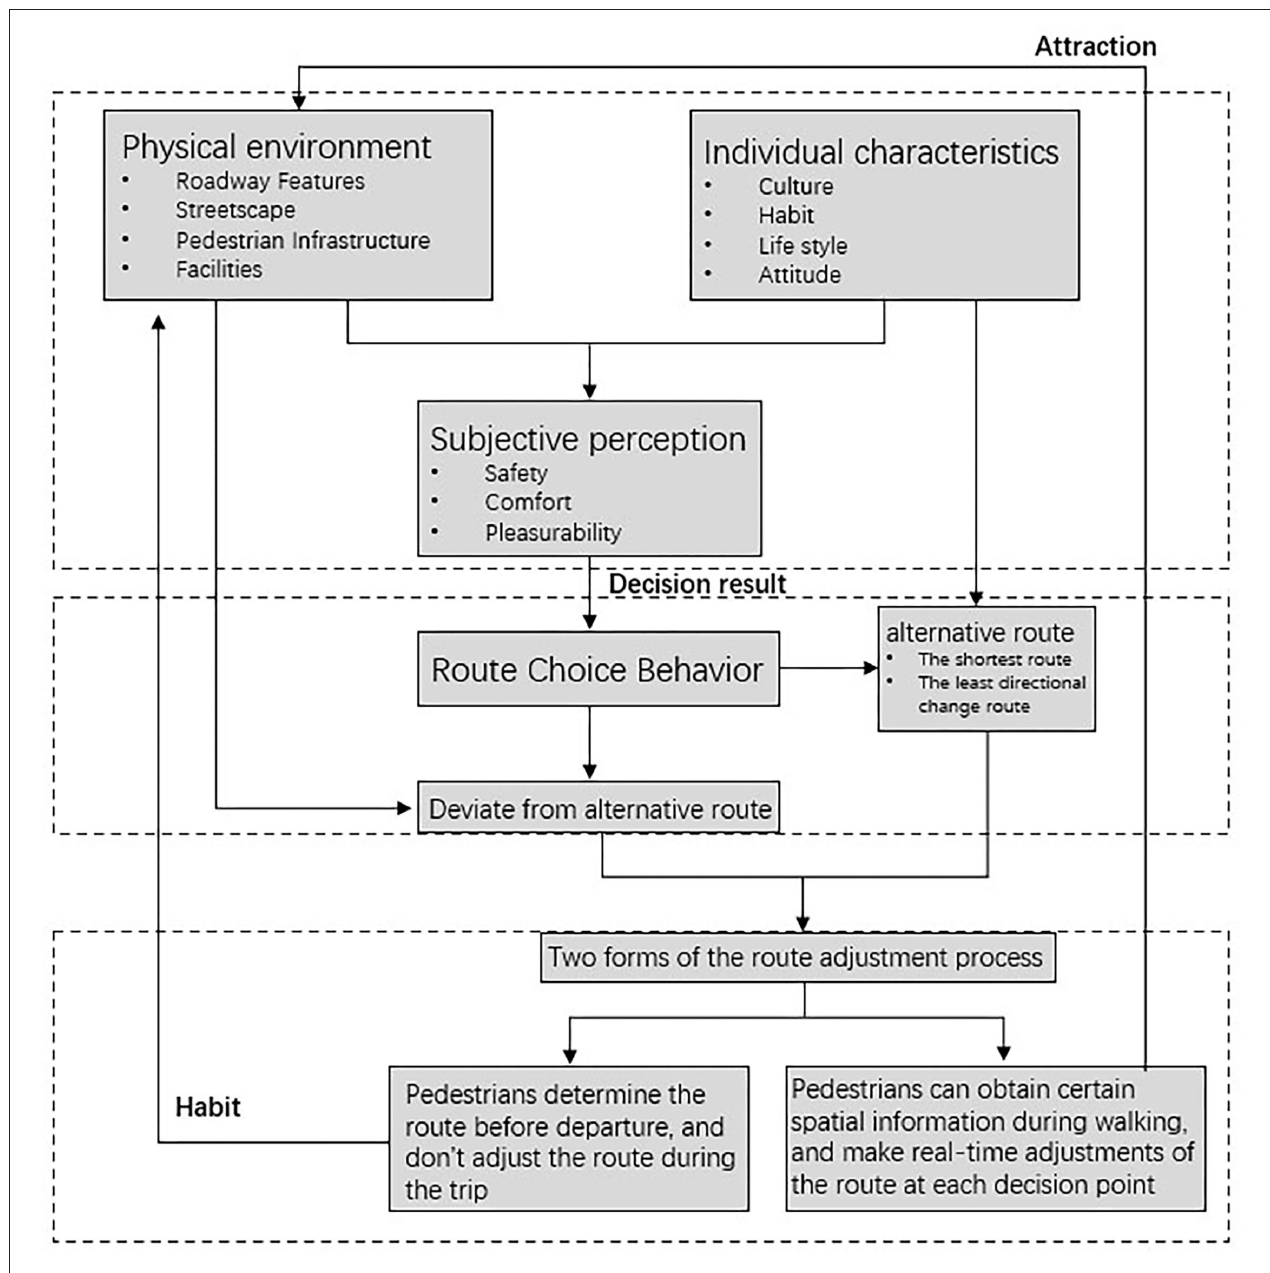
FIGURE 1 | Conceptual framework of street environment and walking behavior.